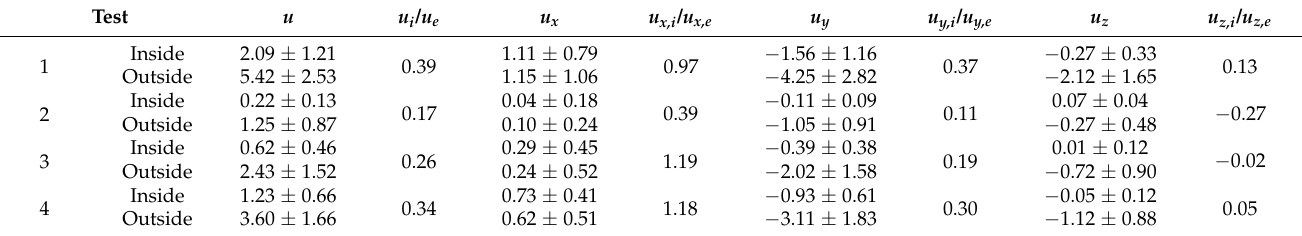
Table 3. Mean values of air velocity u [m s − 1 ], and the three components of the velocity vector field u x , u y and u z [m s − 1 ]. Velocity data represents velocity before and after passing through the IPS of density 13 × 30 threads · cm − 2 . Subscript i and e stands for “inside” and “outside”, respectively.